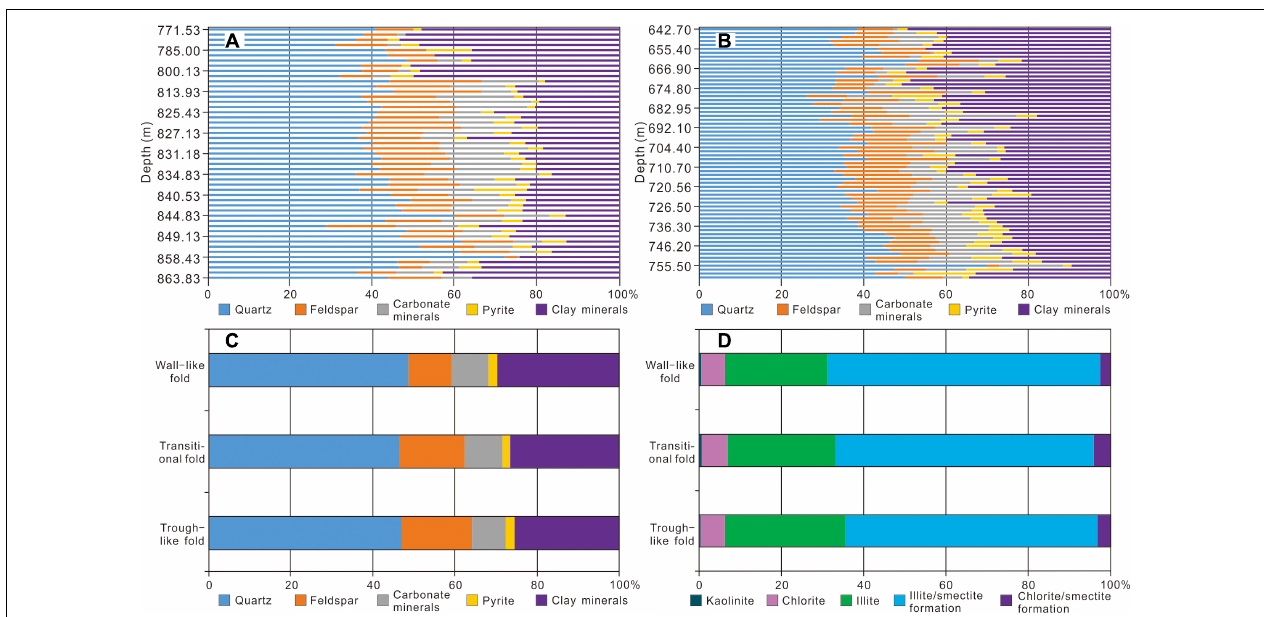
FIGURE 3 | Variation trend of mineral composition in the Wufeng–Longmaxi Formation shale: (A) Vertical distribution map of the shale mineral composition in the Yucan 7 well; (B) vertical distribution map of the shale mineral composition in the Yucan 4 well; (C) shale mineral composition distribution map according to structural style; and (D) shale clay mineral composition distribution map according to structural